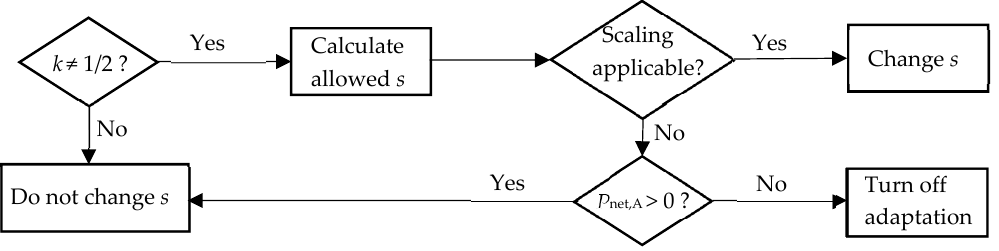
Figure 9. The decision algorithm for the scaling of the adjustment bandwidth.